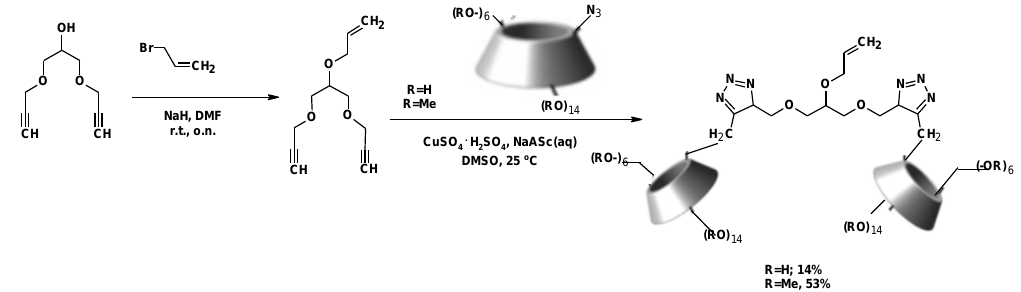
Figure 29. Synthesis of β-CD dimers with a functionalized glycerol linker.